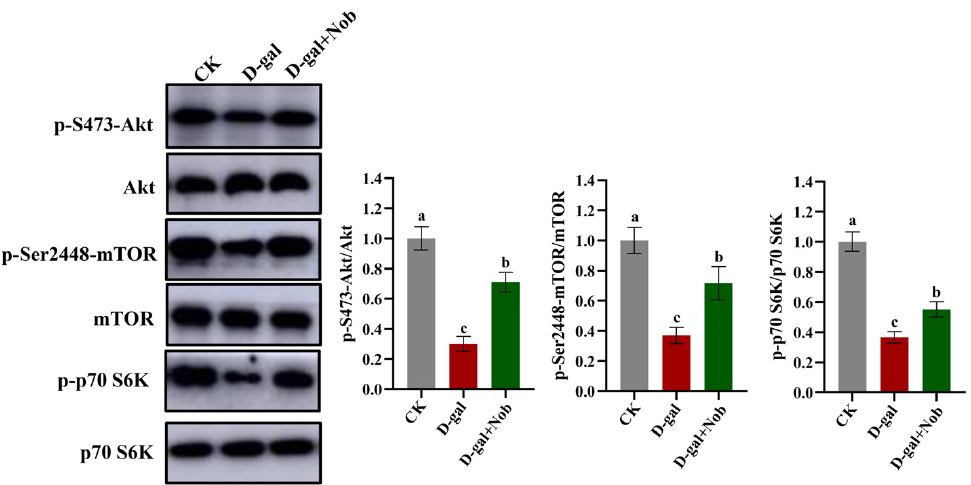
Figure 4. Nob promoted skeletal muscle protein synthesis in D-gal-induced aging mice. Western blot analysis of Akt, p-S473-Akt, mTOR, p-Ser2448-mTOR, p70 S6K, p-p70 S6K and GAPDH in the CK, D-gal and D-gal + Nob groups, n = 3. Significant differences between treatment groups are represented by the lowercase letters a, b, and c ( p <